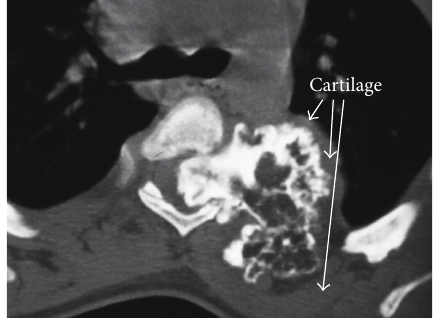
Figure 3: Axial CT of T3 scan showed the extent of the involvement of the left lamina and compression of the cord. The cauliflower appearance corresponds to the ossified matrix of the osteochon- droma (huge intraspinal mass with heterogeneous density). This ossified matrix is surrounded by cartilage tissue, the osseous tumour originating from the left T3–5 facet joint (arrows).